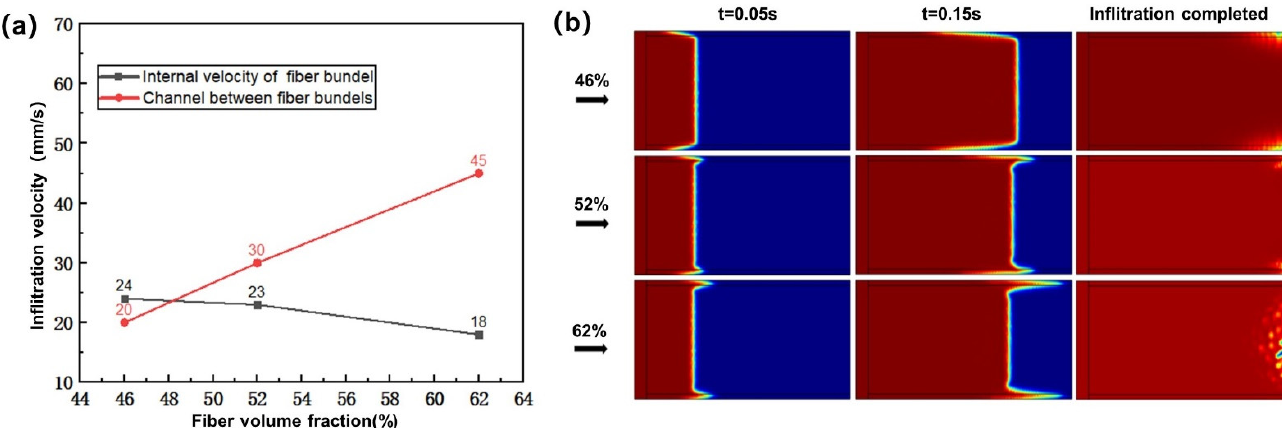
Figure 10. ( a ) Influence of fiber volume fraction on flow velocity. ( b ) Influence of fiber volume fraction on flow front.